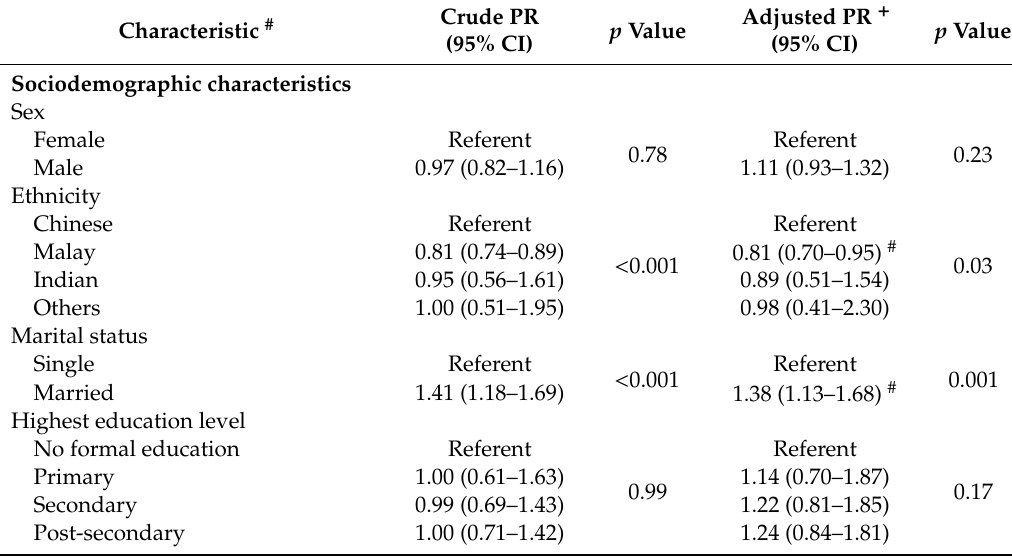
Table 2. Crude and adjusted prevalence ratio (PR) of sociodemographic characteristics, medical history and dietary habits associated with meeting My Healthy Plate recommendation (excluding those on special